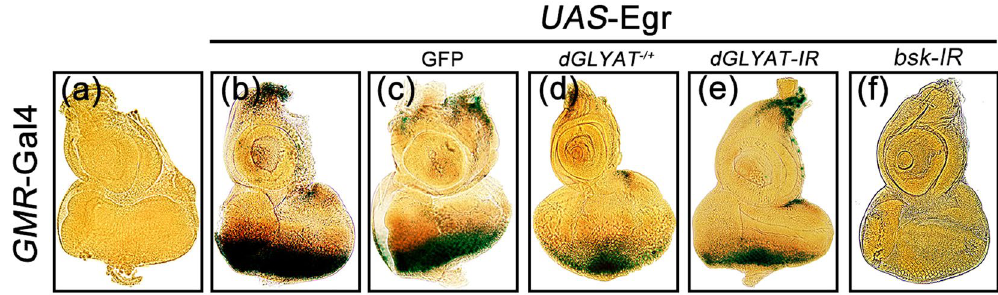
Figure 3. Loss of dGLYAT suppresses ectopic Egr-induced puc expression in eye discs. Light micrographs of Drosophila third instar eye discs with X-Gal staining are shown. Compared with the GMR -Gal4 control ( a ), ectopic Egr-induced puc -LacZ expression in eye discs ( b ) is suppressed by mutation ( d ) or RNAi -mediated depletion ( e ) of dGLYAT . Expression of GFP ( c ) and Bsk-IR ( f ) acts as a negative and a positive control (a, n = 4; b, n = 6; c, n = 8; d, n = 6; e, n = 5; f, n =